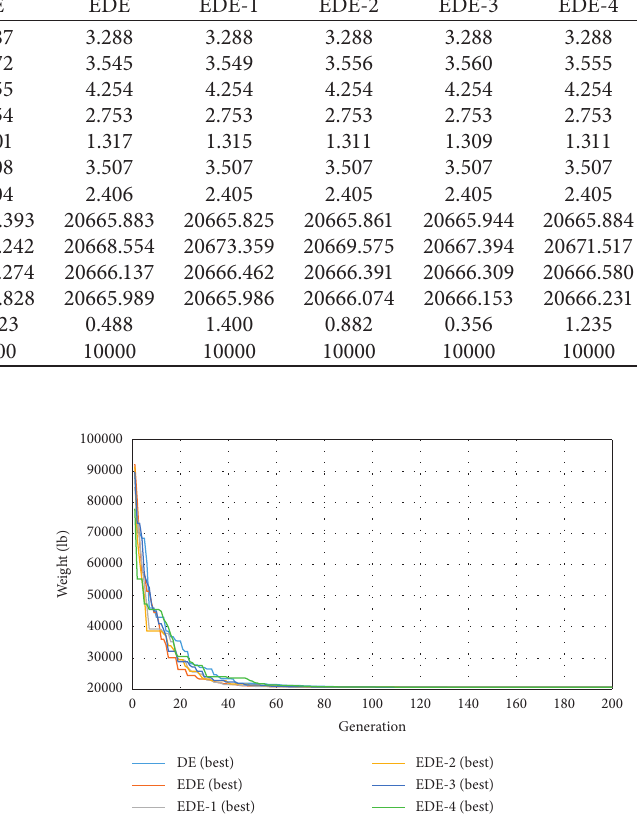
Figure 13: Convergence rates of DE, EDE, EDE-1, EDE-2, EDE-3, and EDE-4 for the 120-bar